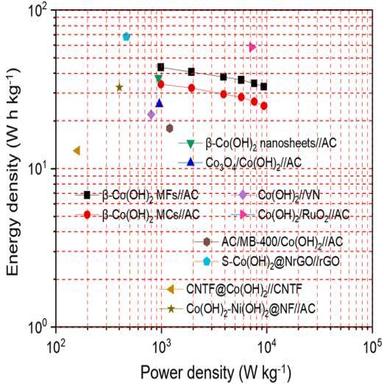
Ragone plots of β-Co(OH)2 MFs//AC HSC, β-Co(OH)2 MCs//AC HSC, and some other Co(OH)2-based SCs reported earlier.